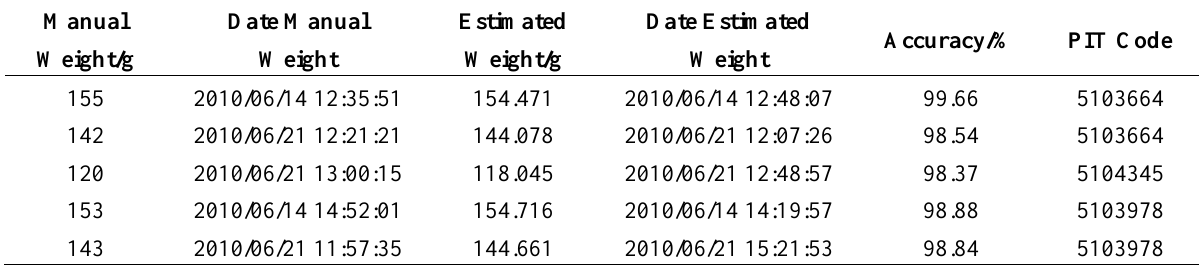
Table 4. Weight accuracy on the basis of sporadic individual captures and the closest in time value offered by the automatic weighing system.